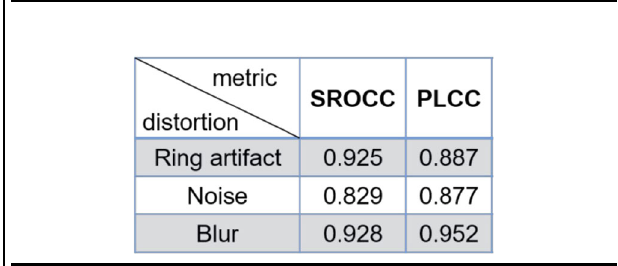
Table 1. Quantitative results of the correlation between predicted quality score and segmentation